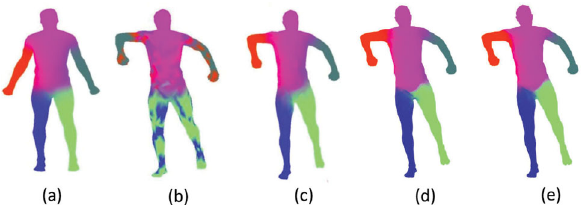
Fig. 11 Comparison with deep learning-based methods. (a) Reference. (b, c) Proposed method without and with the PLS regularization respectively. (d) 3D-coded [38]. (e) FMNet [37].